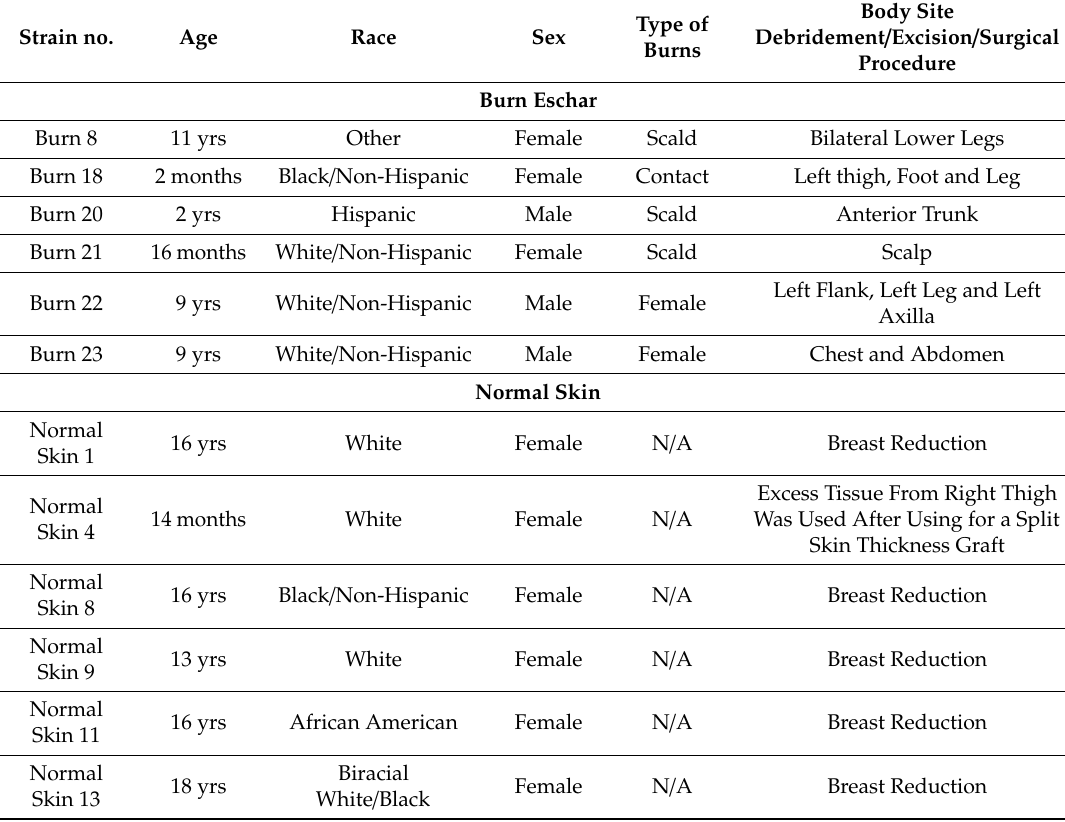
Table 1. Demographic information on burn eschar and normal skin tissues used for pericytes isolation. Strain no. Age Race